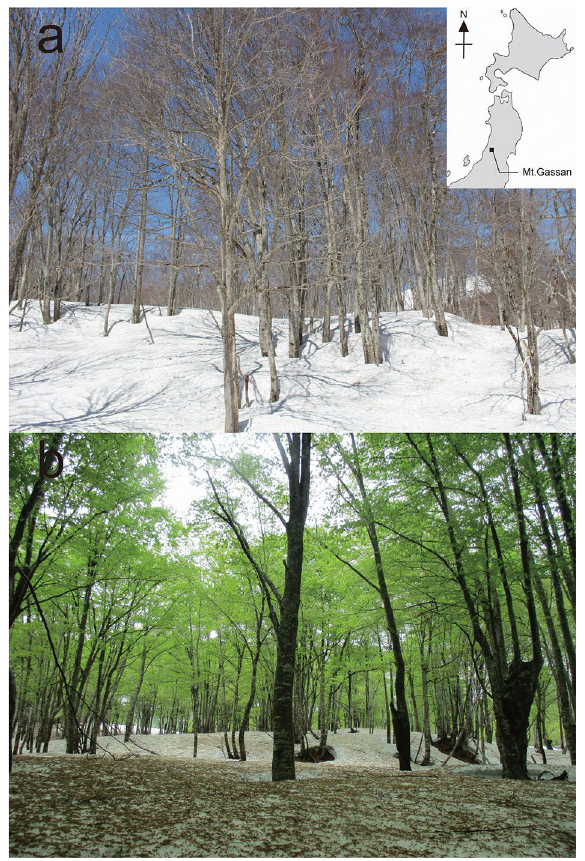
Figure 1. Study site ( a ) in April, 2018 when beech leaf trees did not leaf out yet, ( b ) in May, 2018 (same in May, 2019) when beech came into leaf opened and bud scales were present on snow (insert indicate study area in